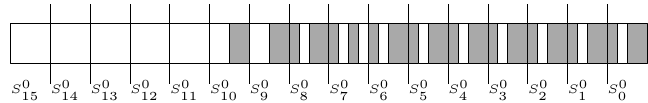
Figure 3: The illustration of the input difference (marked in